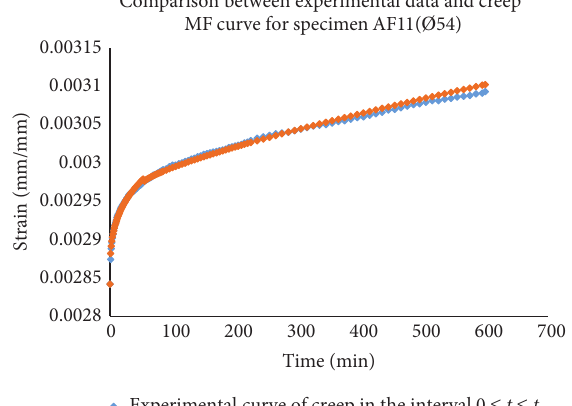
Figure 19: Experimental and MF prediction creep curves of specimen